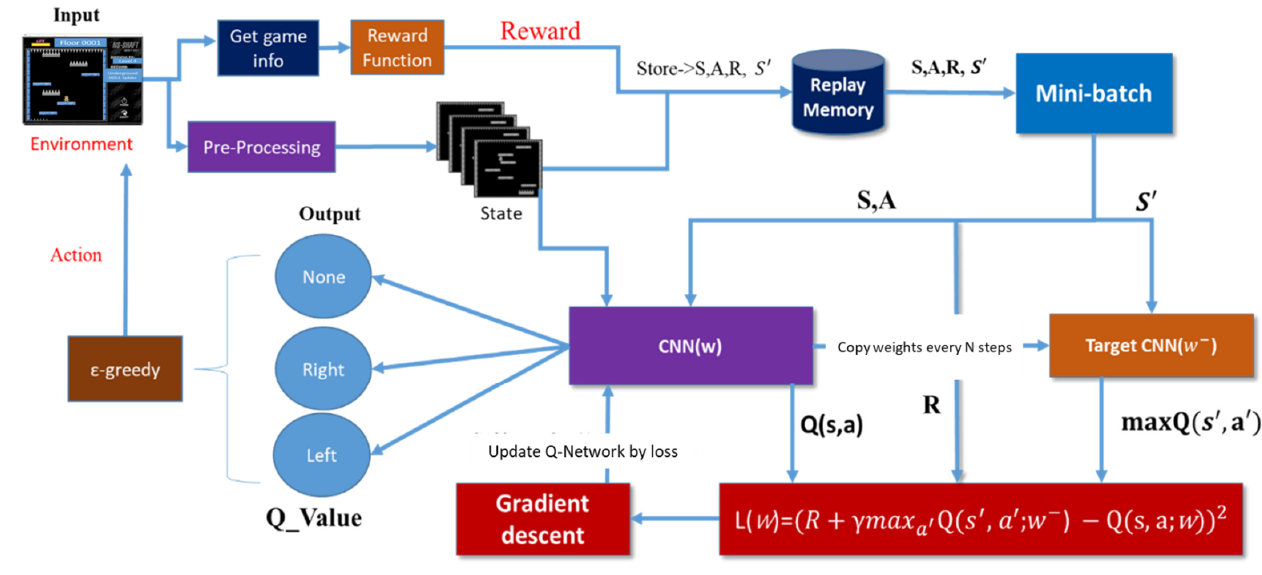
Figure 3. The proposed architecture.